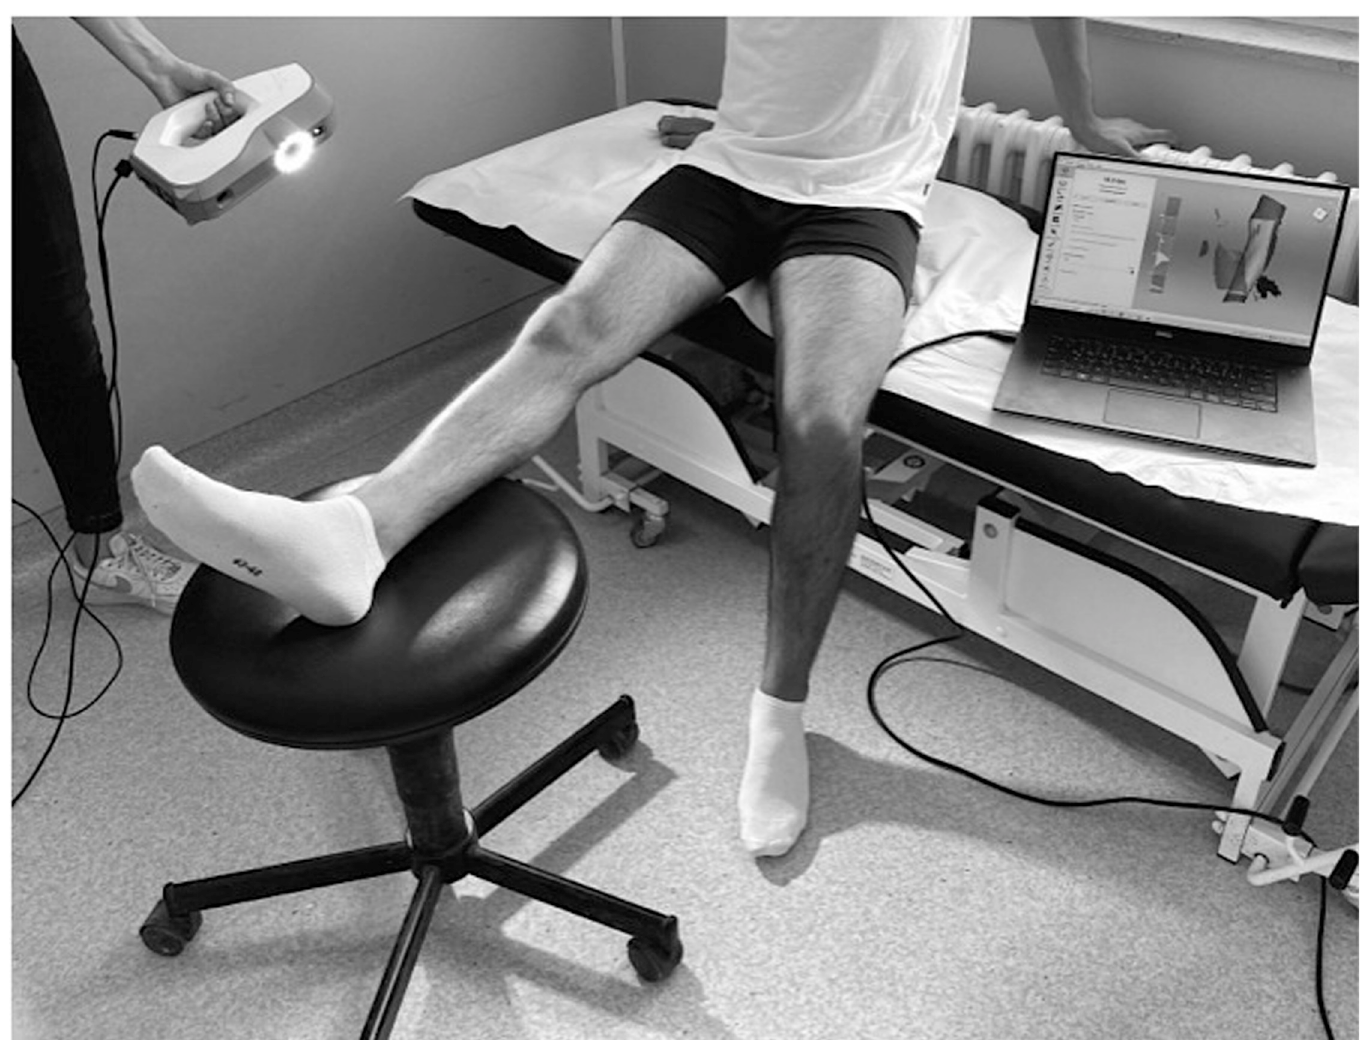
located proximal to the knee joint, between the prefemoral and suprapatellar fat pads. In most (~85%) people, the suprapatellar bursa communicates with the knee joint. The suprapatellar bursa does not communicate with the knee joint in ~15% of people, remaining separated by an embryonic septum [5, 6]. However, we included the suprapatellar bursa in the distal femur. Statistical analysis Statistical analysis was performed using GraphPad Prism (Version 8.1.2, San Diego, California, USA). Data was first tested for normality using D’Agostino-Pearson normality test. Data which showed no normal distribution were further tested using Wilcoxon-Mann-Whitney signed-rank test to compare the volume differences between the left and right leg. P- values � 0.05 were considered significant. An a priori power analysis was performed (G � Power Version 3.0.10, Franz Faul, University of Kiel, Germany). This resulted in a sample size of 10 for a power of 80% with a p value of 0.05 determining